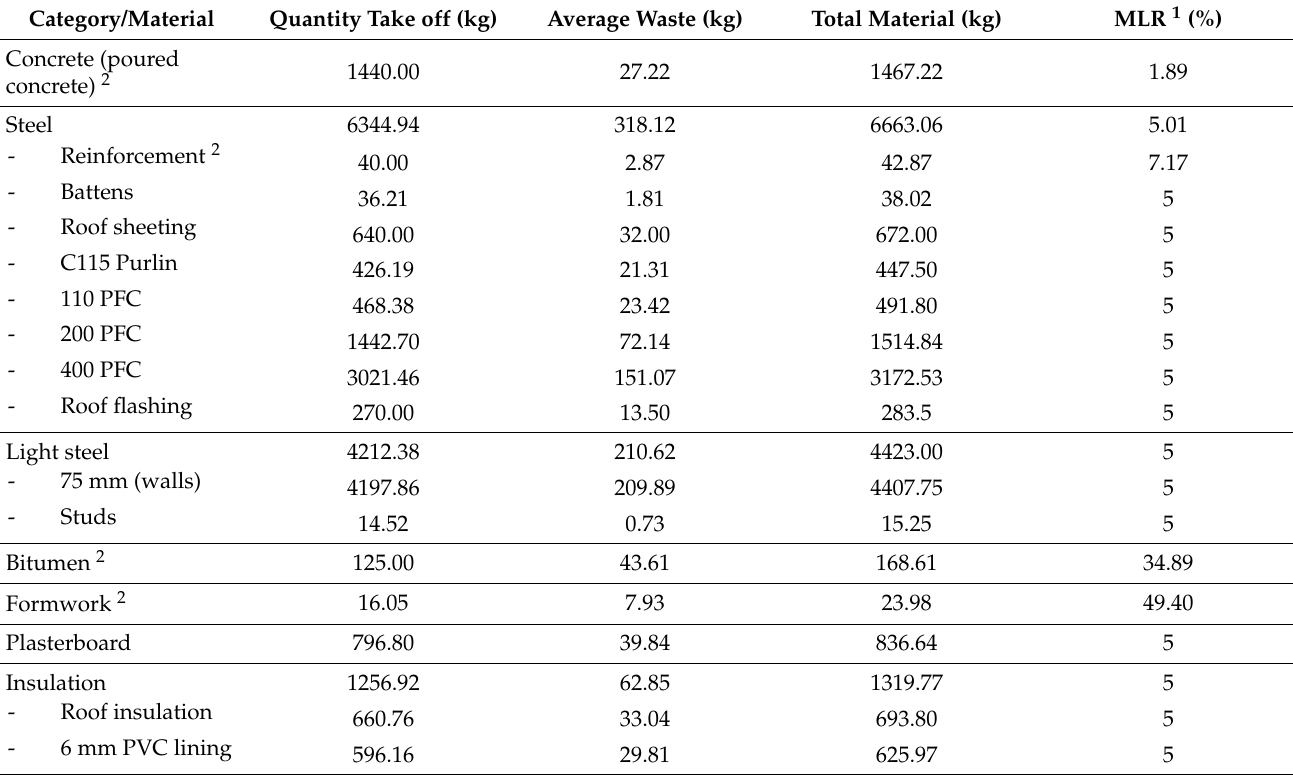
Table 7. Average waste generation for Case A modular construction.